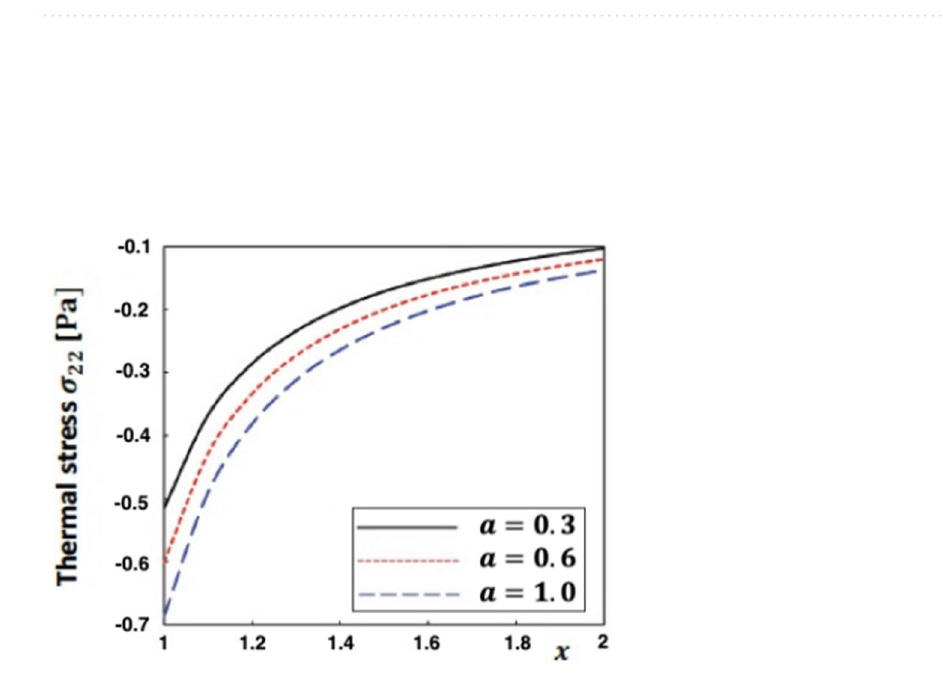
Figure 4. Variation of the thermal stress σ 12 along x -axis for different values of fractional order parameter.